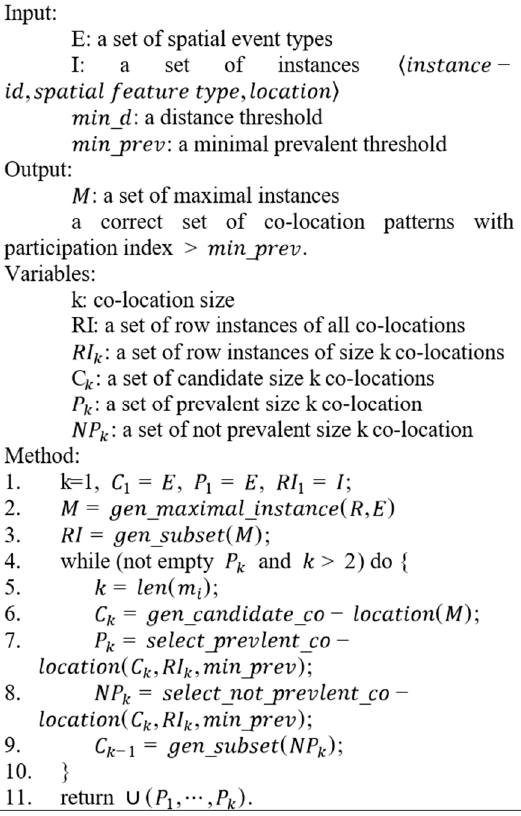
Figure 6. Generation process of a synthetic data set.